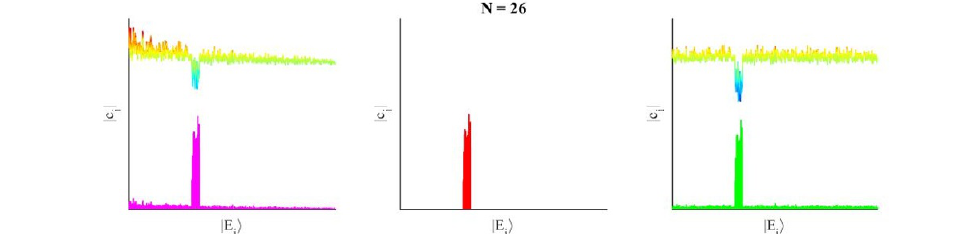
Figure 11 . Distribution of j c i j in non-equilibrium state of the form U ( e S i ) j (cid:9) 0 i (magenta), typical equilibrium state j (cid:9) 0 i (red), and non-equilibrium state of the form U ( S i ) j (cid:9) 0 i (green). The line above the bar plot shows, in heat map colors, which eigenstates are excited, and which ones are suppressed because of the perturbation. Blue eigenstates are suppressed, while eigenstates with other colors are excited with small (green), medium (orange), or large (red)